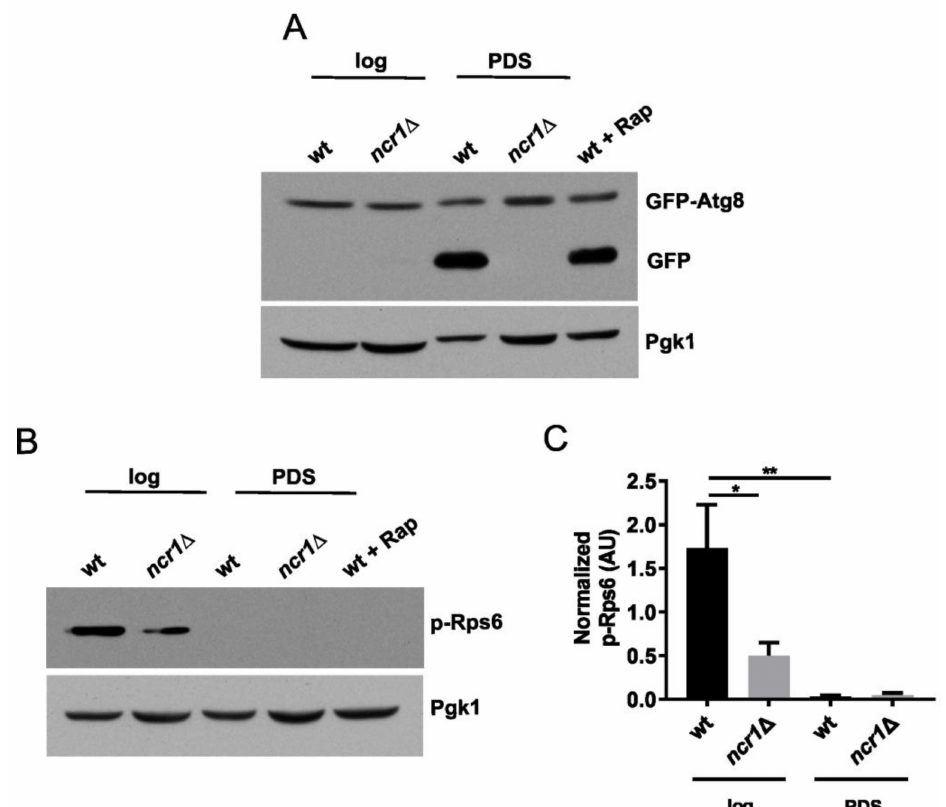
Figure 4. Cells lacking Ncr1 exhibit autophagic defects despite reduced TORC1 activity. ( A ) Wild- type (wt) and ncr1 ∆ cells carrying pRS416- GFP-ATG8 were grown to the exponential (log) and post-diauxic shift [(PDS), 48 h after log] phases, and proteins analyzed by immunoblotting using anti-GFP antibody. As positive control, wild-type cells grown to exponential phase were treated with rapamycin (200 ng mL − 1 ) for 4 h (wt + Rap). The original figure is shown in Supplementary Figure S6. ( B ) Cells were grown to exponential (log) and post-diauxic shift [(PDS), 48 h after log] phases, and the levels of phospho-Rps6 (S232/233), used as read-out for TORC1 activity, were evaluated by Western blotting. Pgk1 was used as loading control. Representative images of at least three independent experiments are shown. The original blots are shown in Supplementary Figure S7. ( C ) Quantification of phospho-Rps6 levels were calculated by the ratio between p-Rps6 and Pgk1 signals. Values are the mean ± SEM. * p ≤ 0.05; **, p ≤ 0.01 (one-way